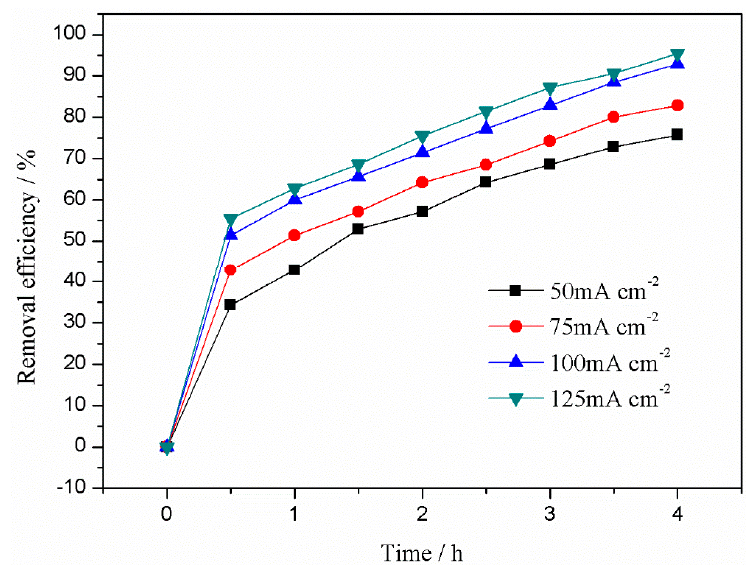
Figure 9. Chloride ion removal efficiency under various current densities.